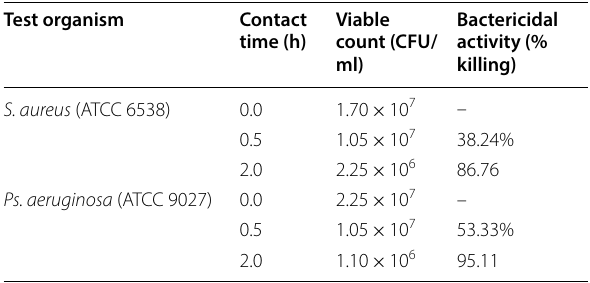
Average of three determinations carried out by surface viable count method at RT (24 °C)